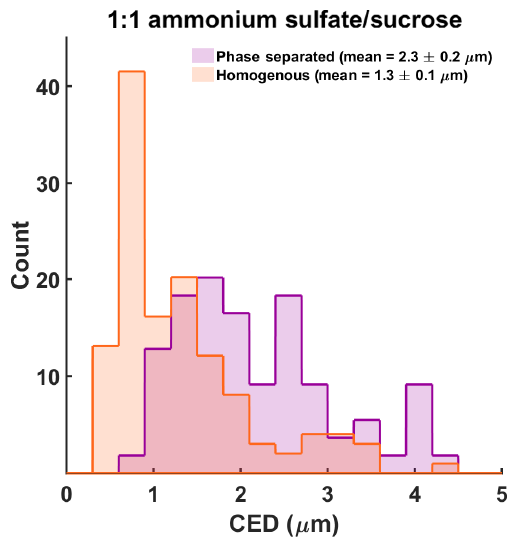
Figure 7. Circular equivalent diameter (CED, also called area equivalent diameter) histogram of homogenous and phase-separated particles, showing that homogenous particles tended to be smaller than phase-separated ones. Particles from stages B, C, and D are included here